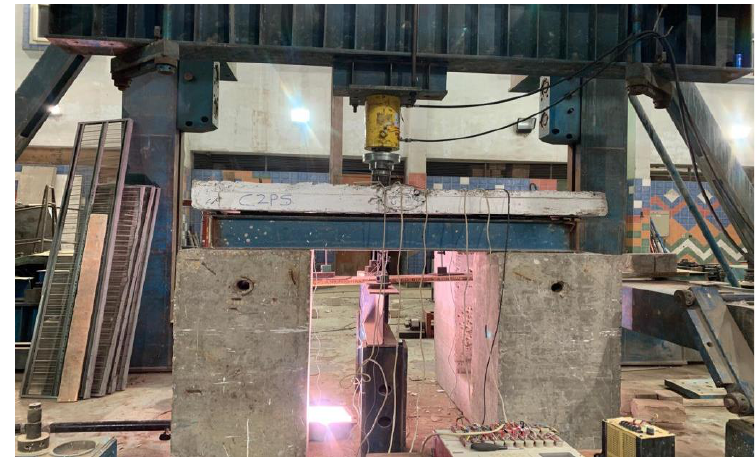
Figure 2. Test set-up for all tested specimens.